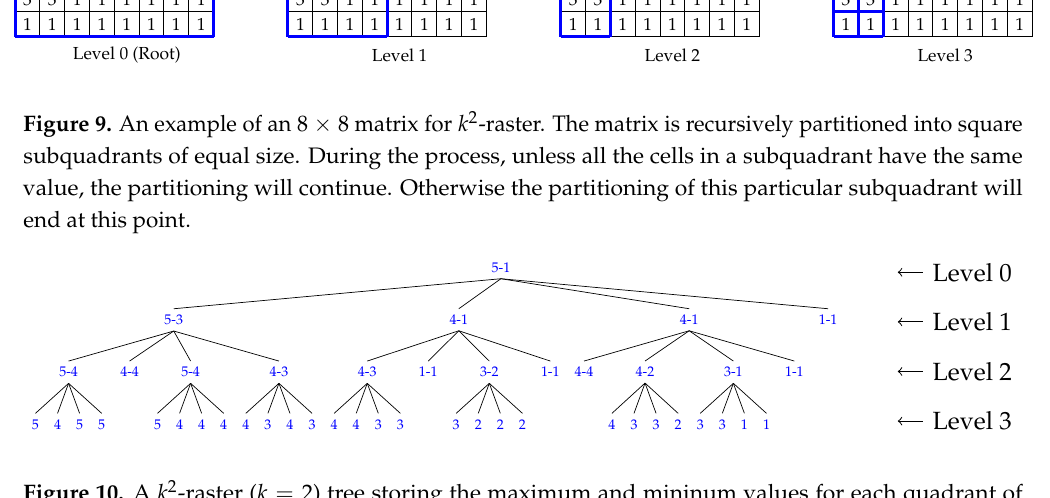
Figure 10. A k 2 -raster ( k = 2) tree storing the maximum and mininum values for each quadrant of every recursive subdivision of the matrix in Figure 9. Every node contains the maximum and minimum values of the subquadrant, separated by a dash. On the last level, only one value is shown as each subquadrant contains only one cell.